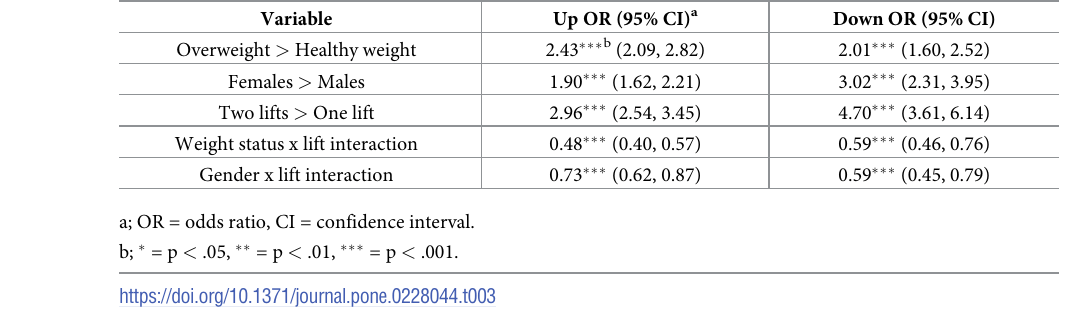
Table 3. Effects of demographics and lift availability on stair avoidance for ascent and descent in